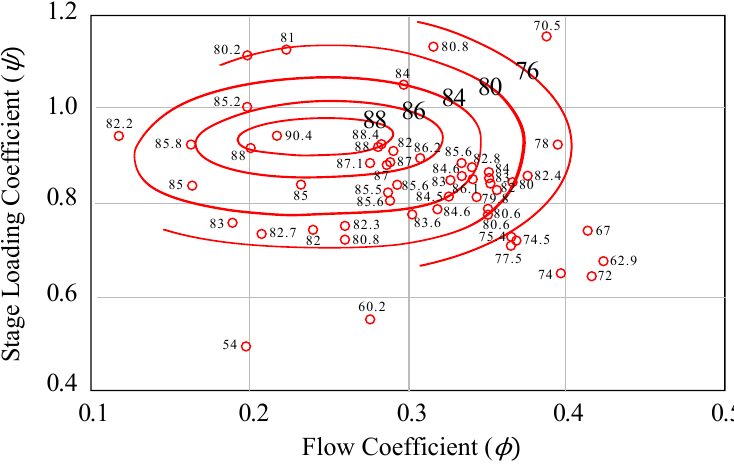
Figure 2. Loading-to-flow ( φ - ψ ) diagram correlations. These data are extracted from Chen and Baines [13] and redrawn by the